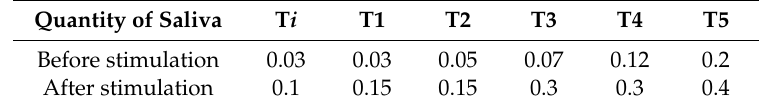
Table 7. Assessment of the quantity of completely resting and stimulated saliva before, during, and after treatment (Q-sal, mL /